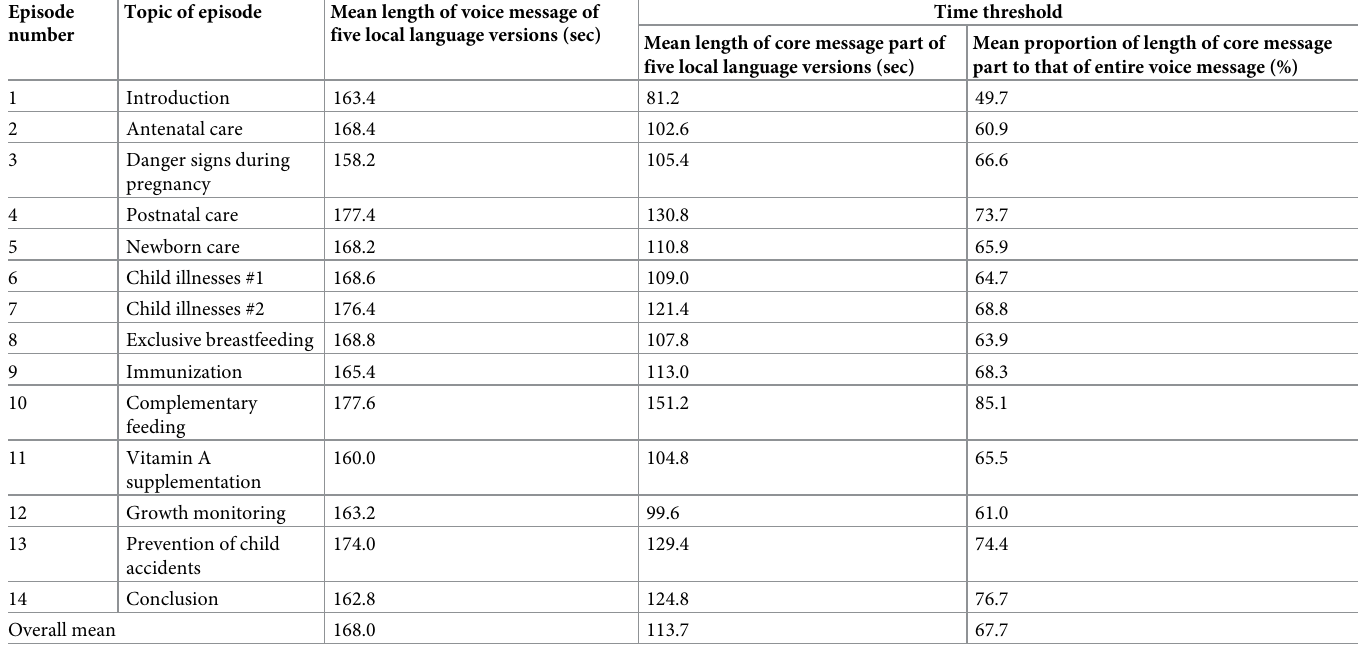
Table 1. Structure of the voice message